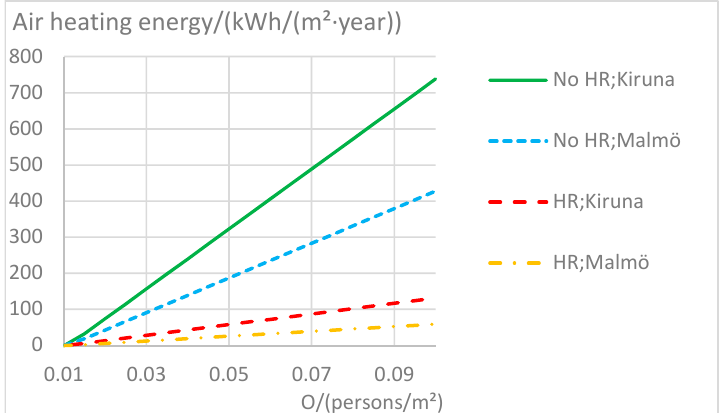
Figure 5. Calculated total heating demand as a function of average occupancy level, O , and heat loss factor, Q , for the building with outdoor climate from Malmö. ‘HR’ means heat recovery.